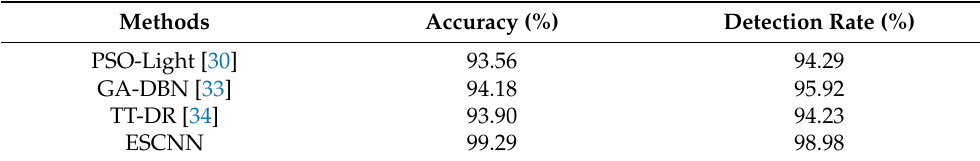
Figure 7. False Alarm Rate. Table 4. Attack Detection Rate. Table 4. Attack Detection Rate.